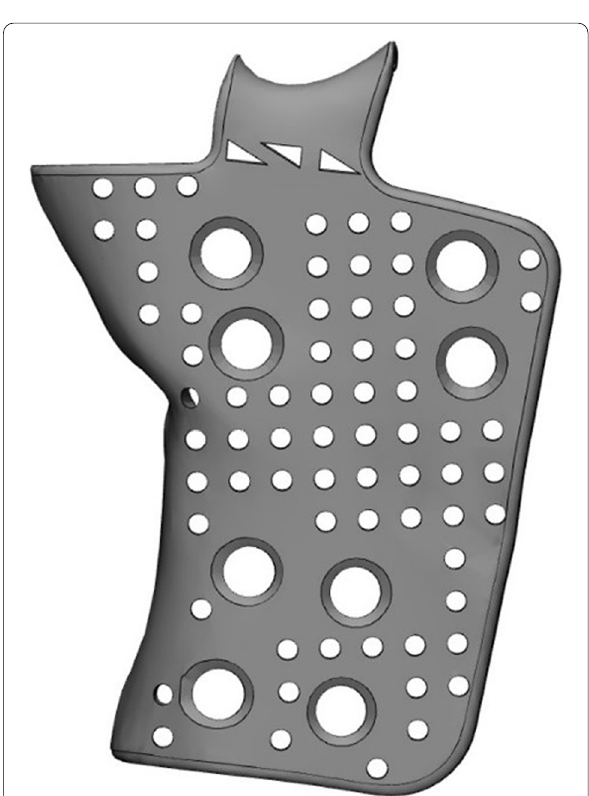
Fig. 4 Case 10 – a titanium-reinforced plate to stabilise a mandibular pathologic fracture; a detachable flange is designed at the upper aspect to match with the sigmoid notch as a